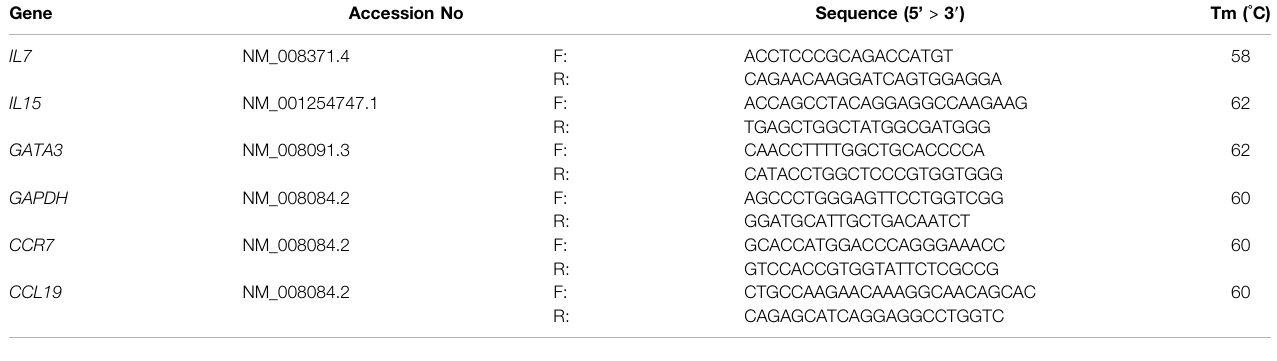
TABLE 1 | Primer and probe sequences for quantitative reverse transcription-polymerase chain reaction analyses.